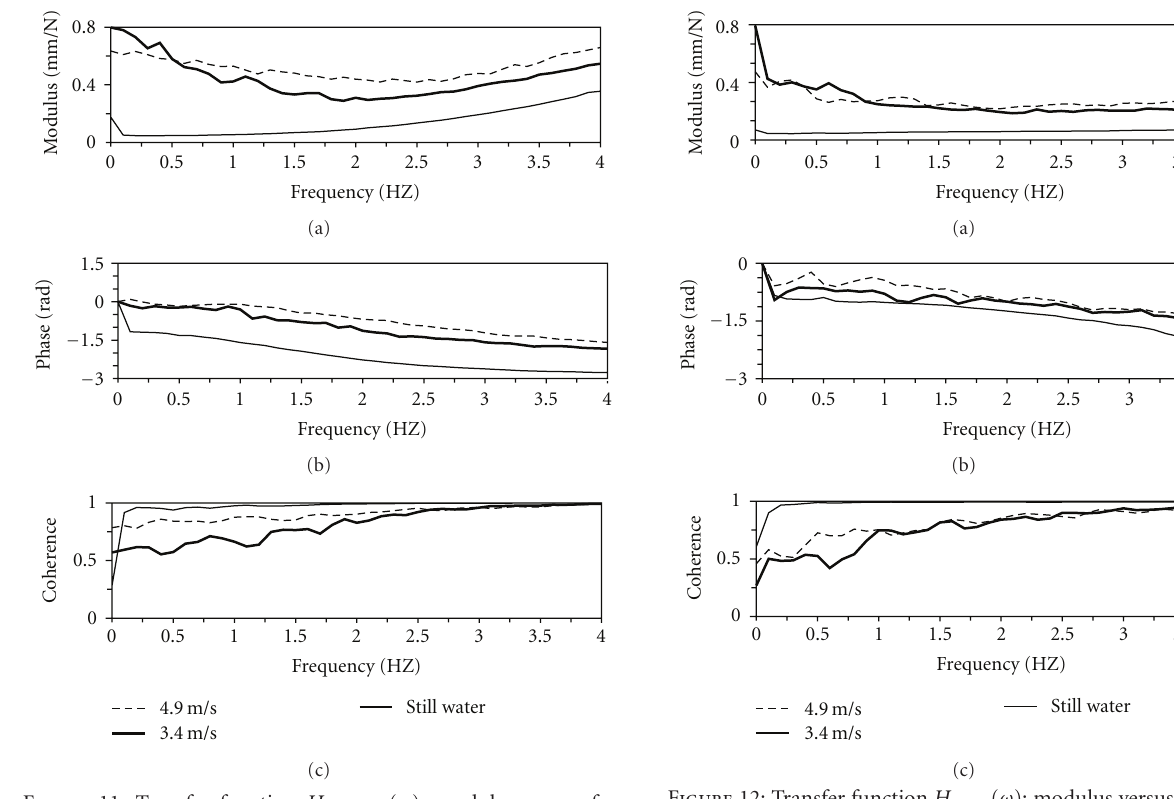
Figure 11: Transfer function H transversal ( ω ); modulus versus fre- quency (a), phase versus frequency (b); coherence between f transversal and u central versus frequency (Hz) (c); in still water, and for 3.4 m/s and 4.9 m/s fluid velocities.